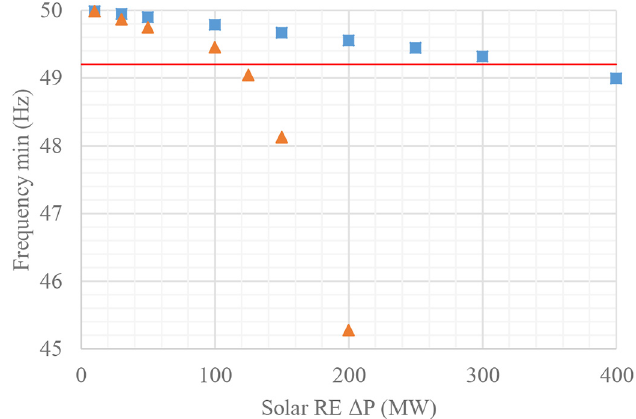
Fig. 9. Frequency dip as a function of the variable solar RE magnitude drop with and without thermal support.